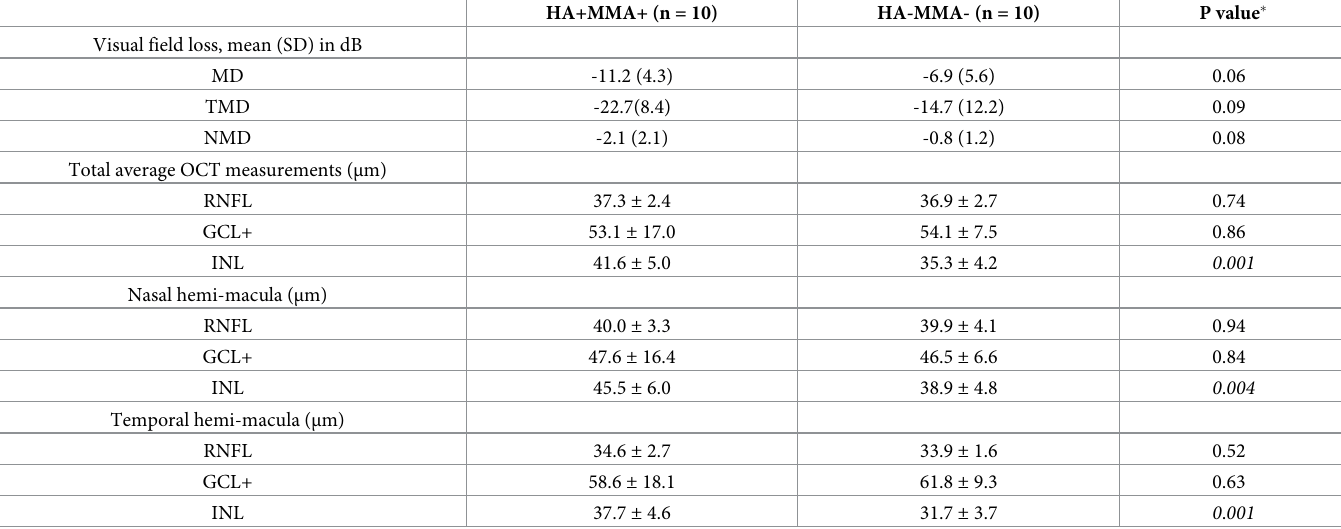
Table 3. Comparison of visual field and inner retinal layer thickness measurements in two subsets of eyes with temporal hemianopia and band atrophy of the optic nerve, with or without hiporeflective abnormality on near infrared photography and microcystic macular abnormality on OCT (HA+MMA+ and HA-MMA-, respectively).